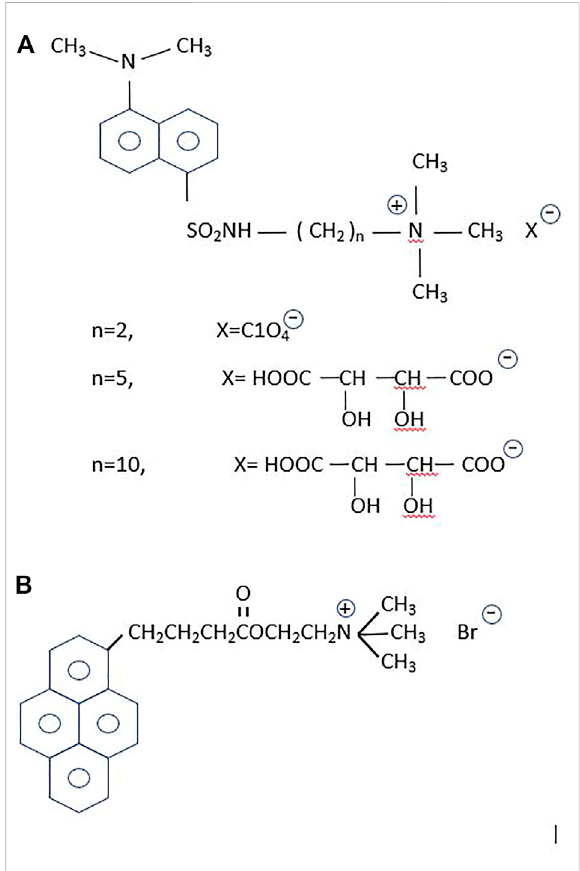
FIGURE 2 Fluorescent probes for the cholinergic system. (A) The dansyl-series. From top to bottom: n = 2, the primal compound, dansyl-choline [1-(5-dimethylaminonaphtalene-1-sulfonamido) ethane-2 trimethylammonium perchlorate] (Weber et al., 1971); n = 5, [1-(5-dimethylaminonaphtalene1-sulfonamido) pentane-5- trimethylammonium tartrate], and n = 10, [1-(5- dimethylaminonaphtalene1-sulfonamido) decane-10- trimethylammonium tartrate] (Narayanan and Balaram, 1978). According to these authors the n = 5 and n = 10 were intended to increase hydrophobicity and hence enhance the partitioning in lipid membranes of the dansyl homologous compounds, which were employed in binding studies on the enzyme cholinesterase. (B) 1-pyrene-butyryl choline, an antagonist of the